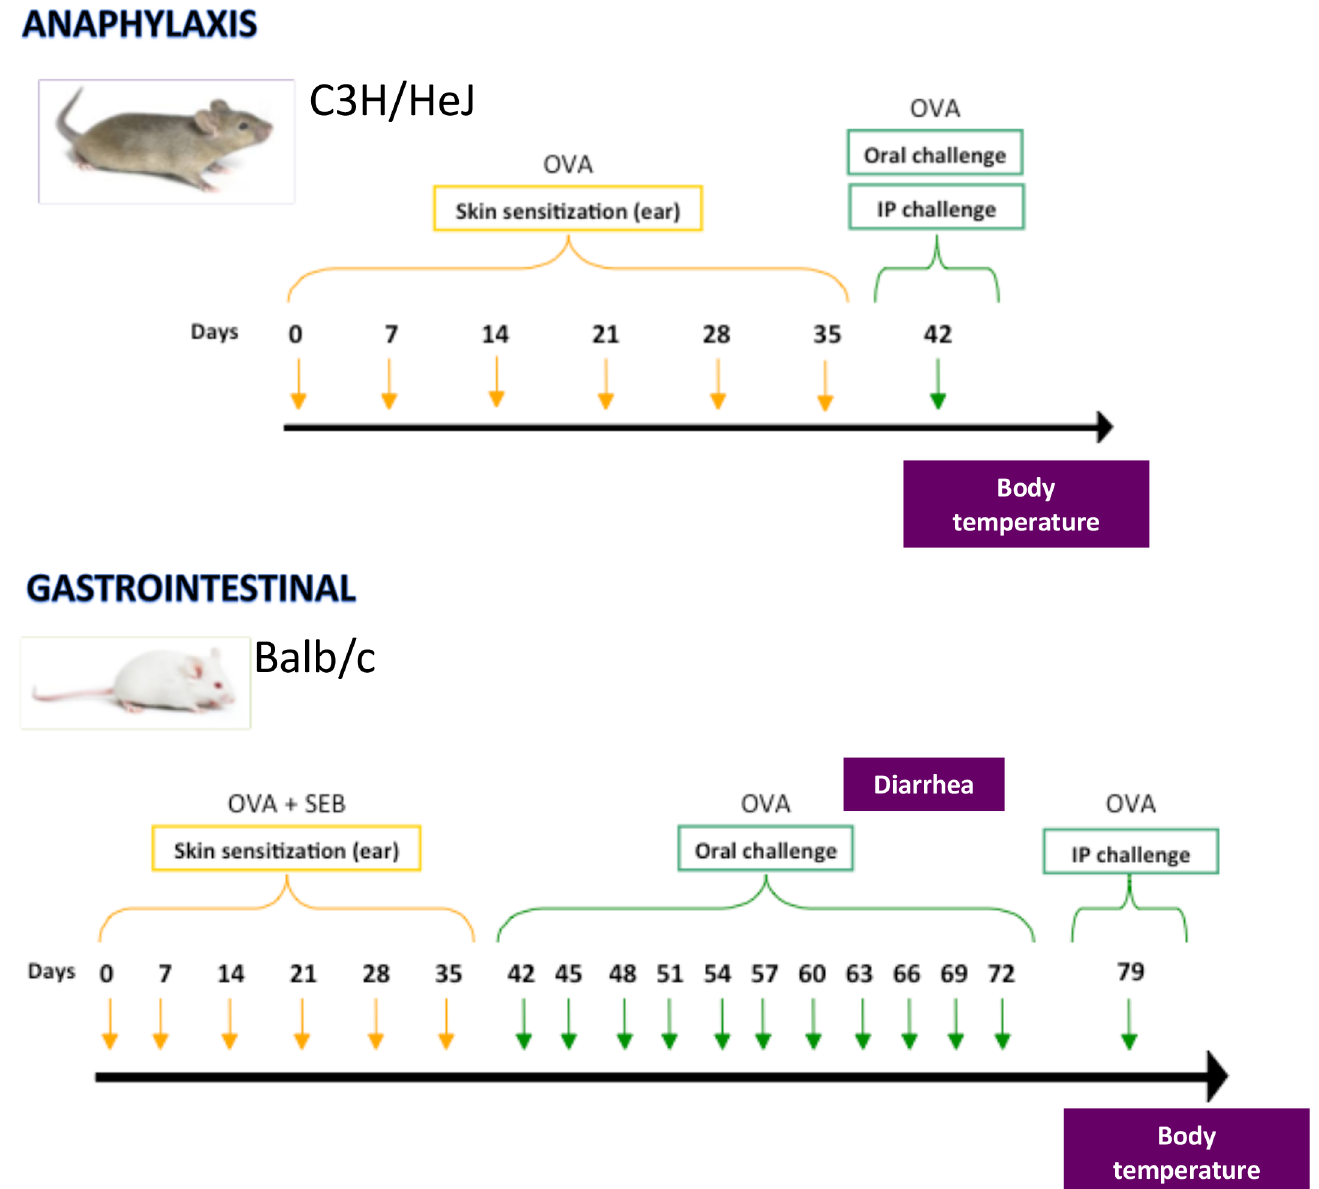
Fig 1. Mouse models of food allergy: Protocols of sensitization to OVA and induction of anaphylaxis in C3H/HeJ mice (A) and allergic diarrhea in Balb/c mice (B).